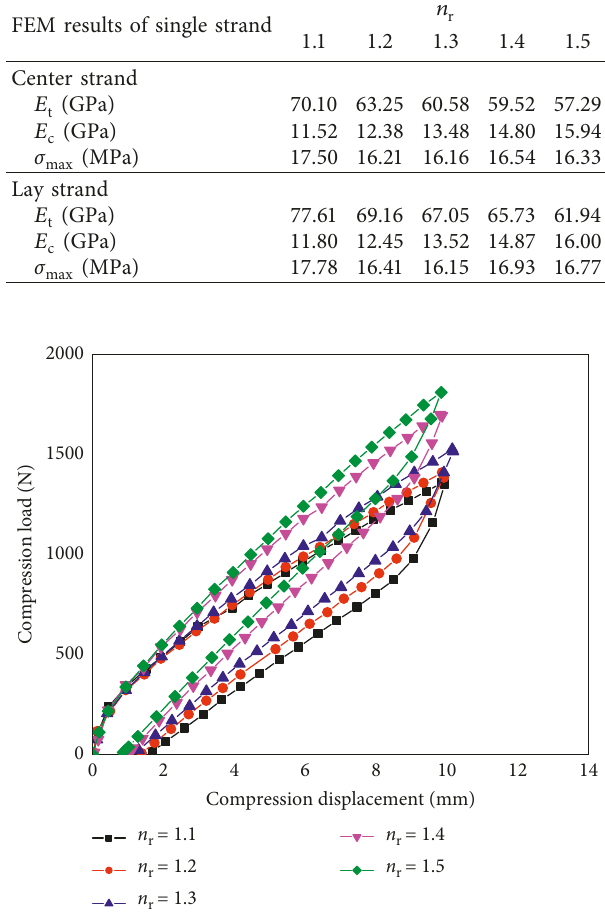
Figure 4: Hysteresis curves comparison of the GGQ-99 WRI with different diameter